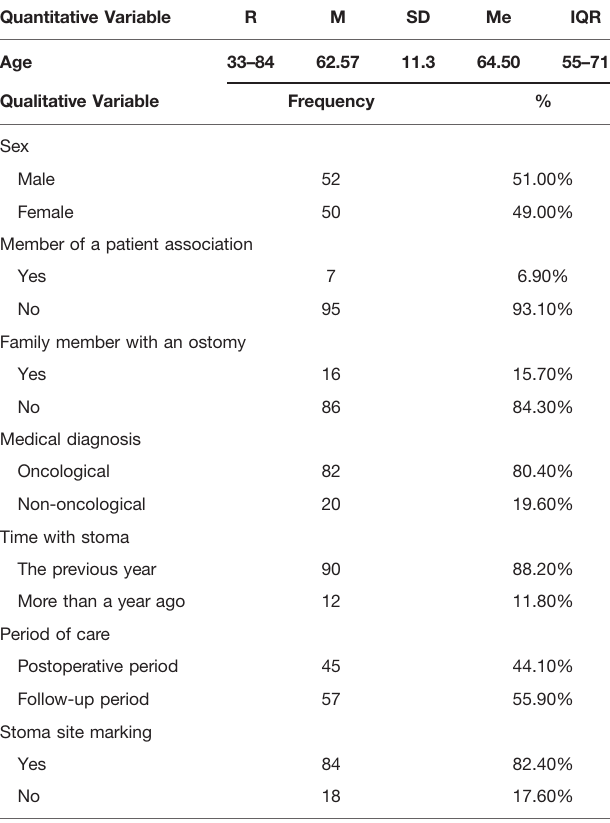
TABLE 1 | Sociodemographic and clinical characteristics of the sample. Quantitative